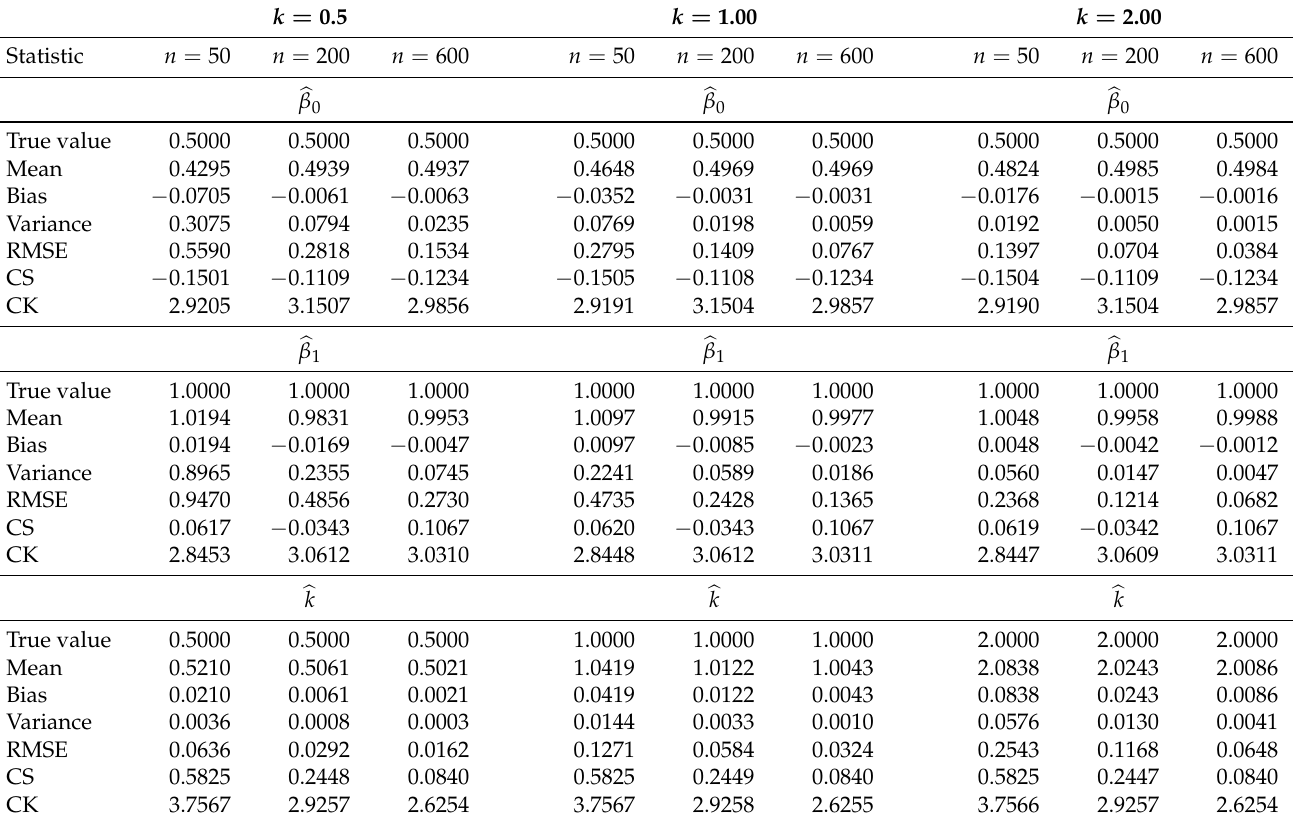
Table 4. Statistics from simulated Weibull regression data ( q = 0.90, β 0 = 0.50, β 1 = 1.00). k = 0.5 k =